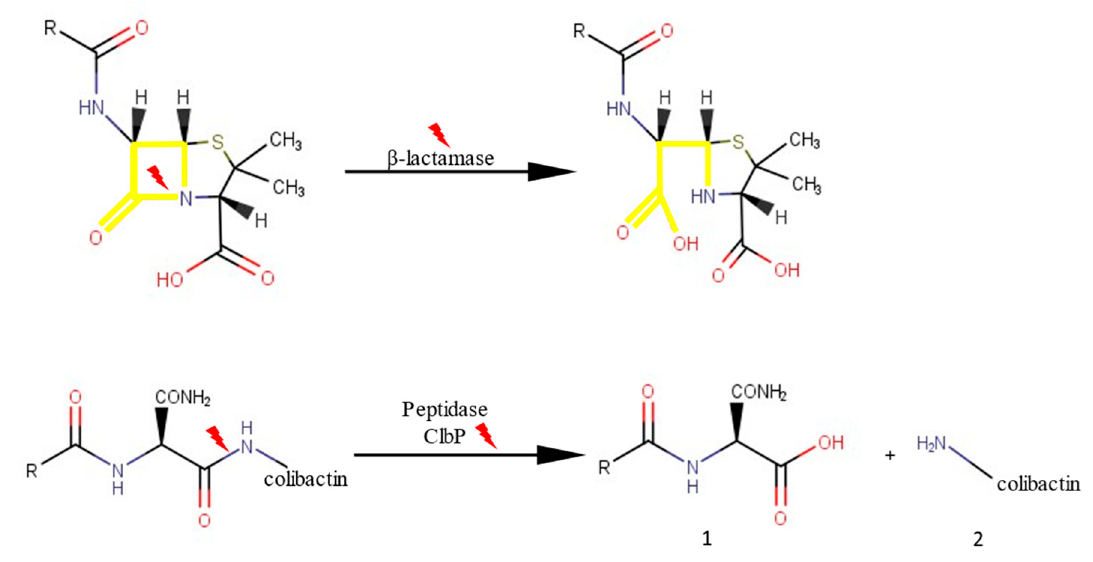
Figure 4. Comparison between chemical cleavage of β -lactamase and the clbP gene. The chemical structure was creating using MarvinView version 22.1.0.